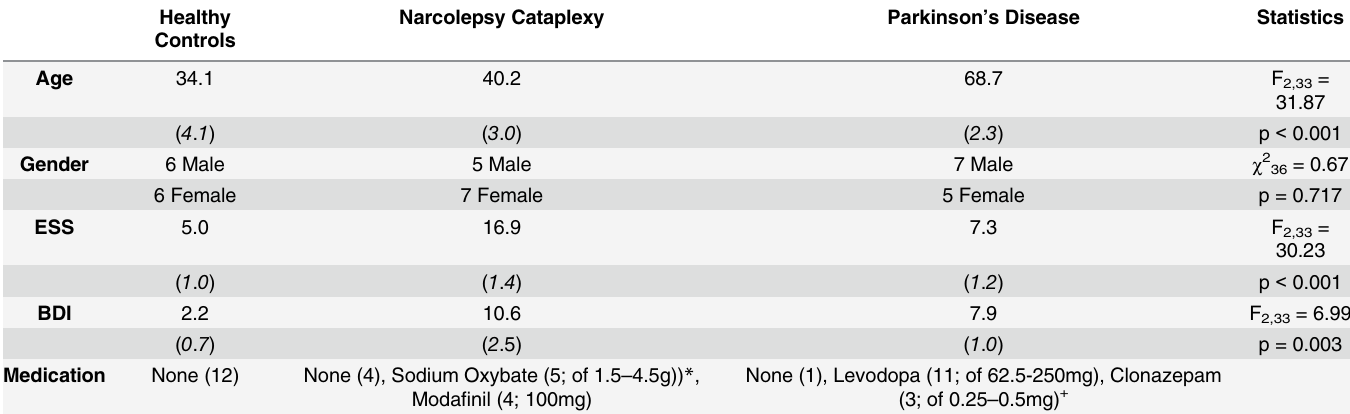
Table 1. Participant demographic overview including statistical analysis of population